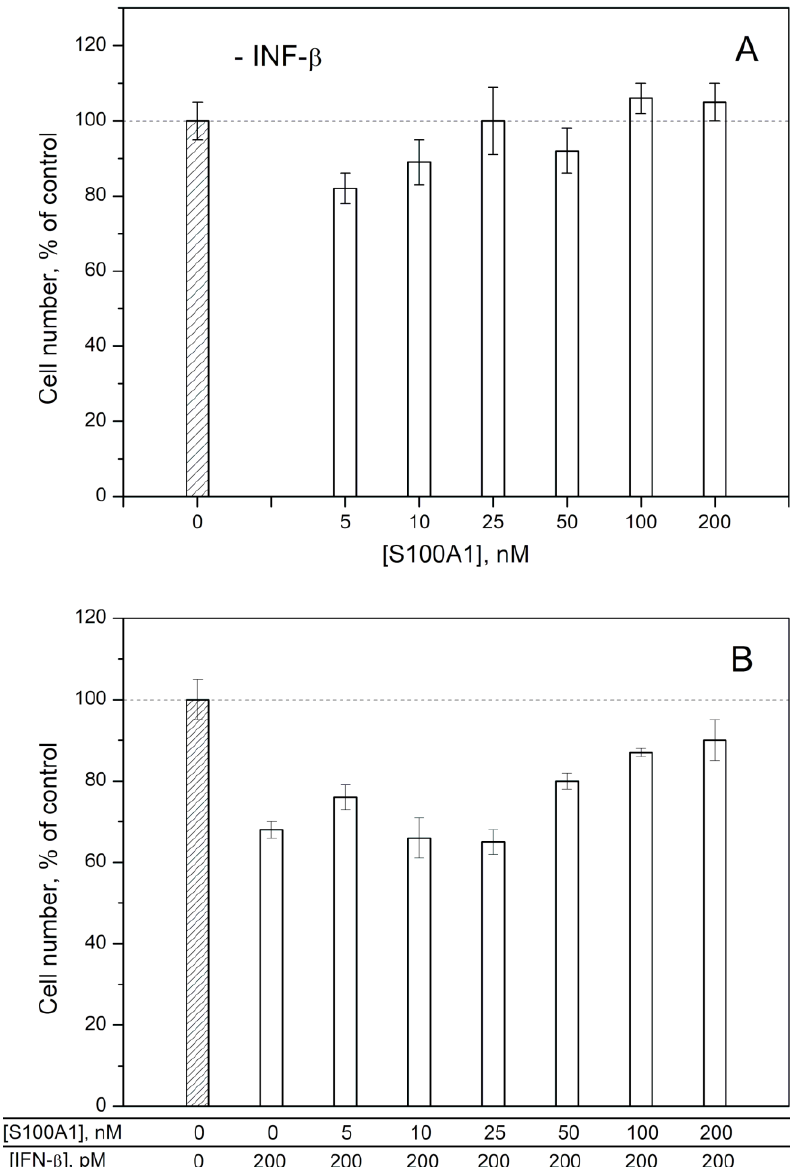
Figure 4. Viability of MCF-7 cells treated by S100A1 protein (panel A ), IFN- β or their combination ( B ) measured by crystal violet assay.